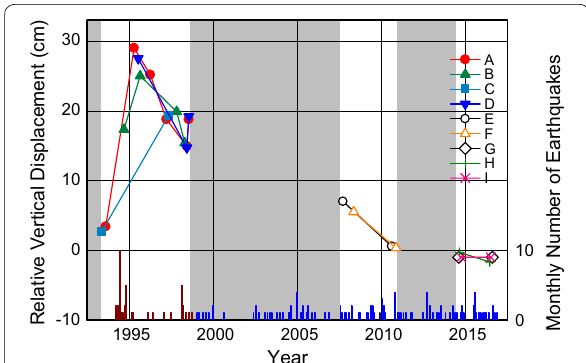
Fig. 9 Temporal evolution of the maximum vertical displacement in each interferogram near the center of the deformation field. Each time series A – I shows independent time change defined in Table 1. In this figure, each time series is shifted vertically to show the smallest variation between the time series. Gray areas show no periods with InSAR data, and the vertical displacement time series do not have the same relationship with each other before and after the gray areas. Monthly number of earthquakes within the region (Fig. 2) is also plotted: Brown bars show those from 1993 to 1998 after Earthquake Research Institute (2002), and blue bars show those from 1999 to 2016 processed by the Japan Meteorological Agency (JMA). Earthquakes include those with magnitudes of more than 0.3 and depths shal- lower than 20 km. Given the revisions of observation points (etc.), the quality of seismic data is not uniform over